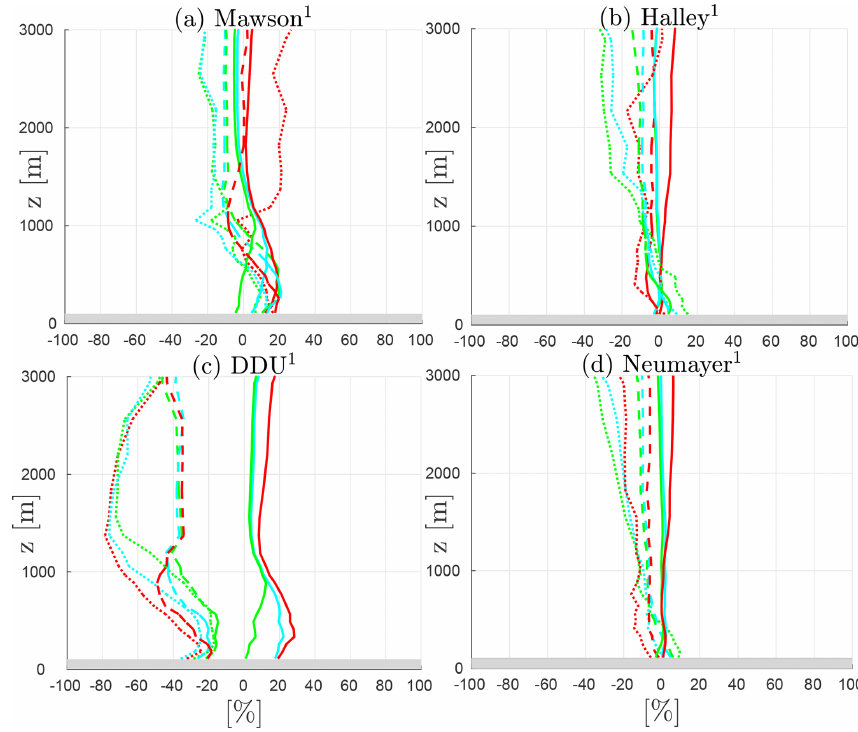
Figure 9. Yearly median differences (solid lines), 80–20th interquartile difference (dashed lines) and 95–5th interquartile difference (dotted lines) with respect to radiosoundings for RHi during precipitation events at the Mawson, DDU, Halley and Neumayer stations. Red, green and cyan lines refer to Polar WRF, ERA5 and ERA-I, respectively. Grey strips delimit the first 100m above the ground surface. Polar WRF and ERA reanalyses are conditioned to radiosounding times. Mind the different horizontal axis compared to Fig.